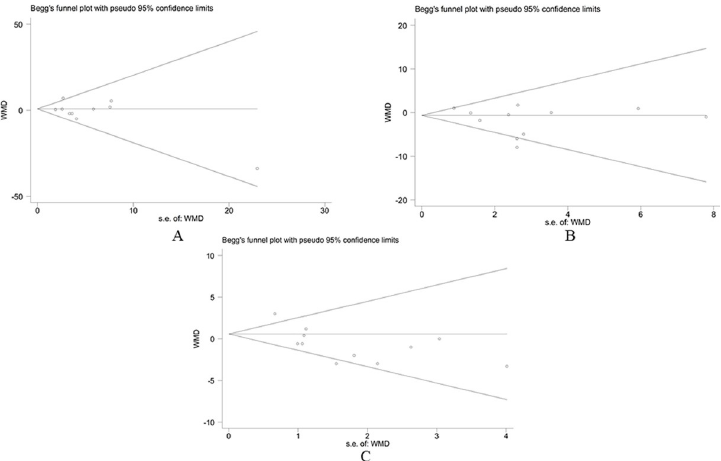
Fig 8. Publication bias analysis of fasting plasma glucose, systolic blood pressure, and diastolic blood pressure. (A) fasting plasma glucose, (B) systolic blood pressure, (C) and diastolic blood pressure.